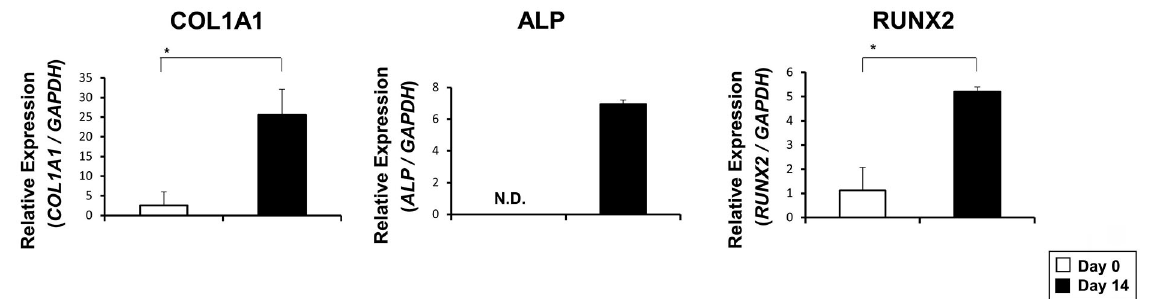
Expression of COL1A1, TNAP, and RUNX2 analyzed using RT-qPCR. mRNA levels were normalized to those of 18S rRNA. Experiments were performed in triplicate. Values represent the mean ± SD, n = 3. Wilcoxon’s rank sum test was applied for comparisons; *p<0.05. Figure 5- Expression of osteoblast markers after OBM